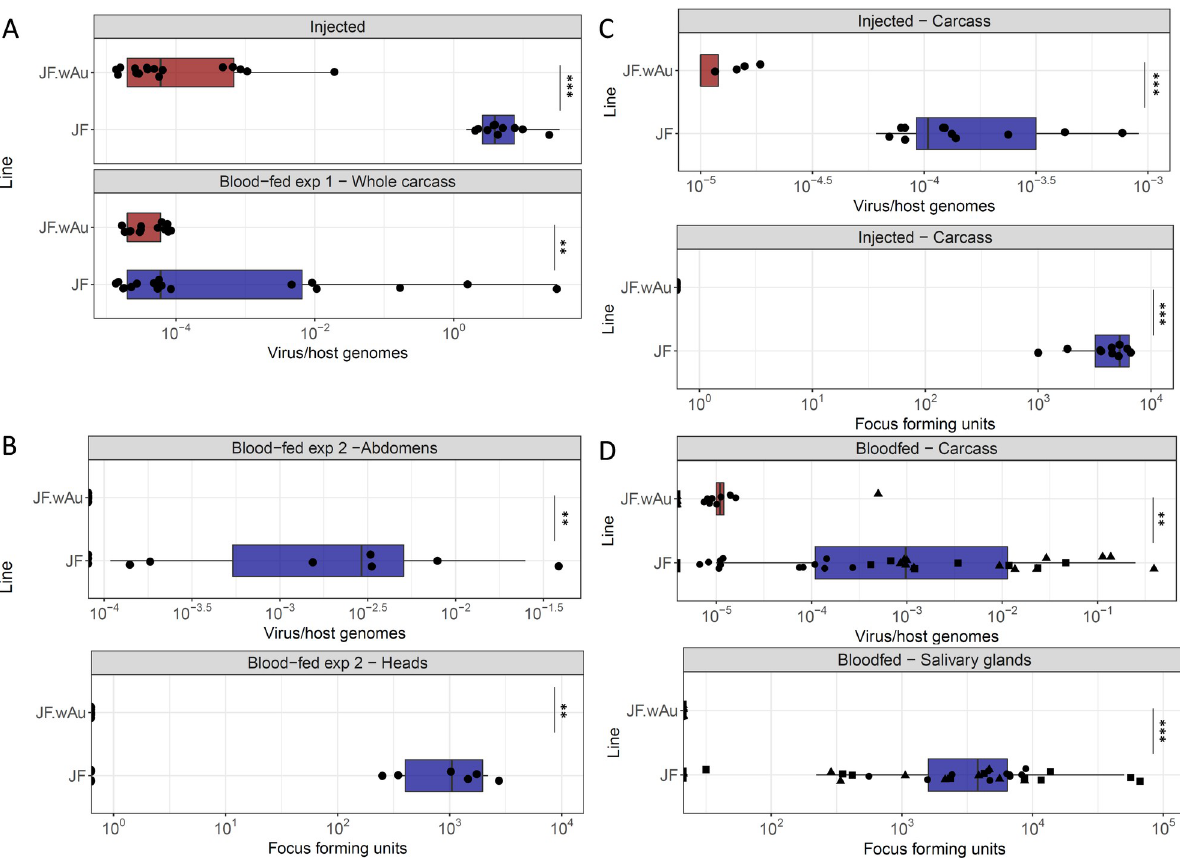
Fig 4. DENV2 and ZIKV challenges of JF. w Au and wild-type mosquitoes. A) DENV2 genome copies were quantified in whole bodies of 3–5 day old mosquitoes using qPCR on injected and blood-fed females after 14 days. B) Viral genome copies and foci number were quantified after a DENV2-infected blood meal on abdomens and heads. C) ZIKV genome copies (in carcasses) and viral foci number (in dissected salivary glands) of injected and D) blood-fed 3–5 day old mosquitoes. The latter graph summarises three independent biological replicates; different shapes represent data points from each replicate. p < 0.001, ��� p <